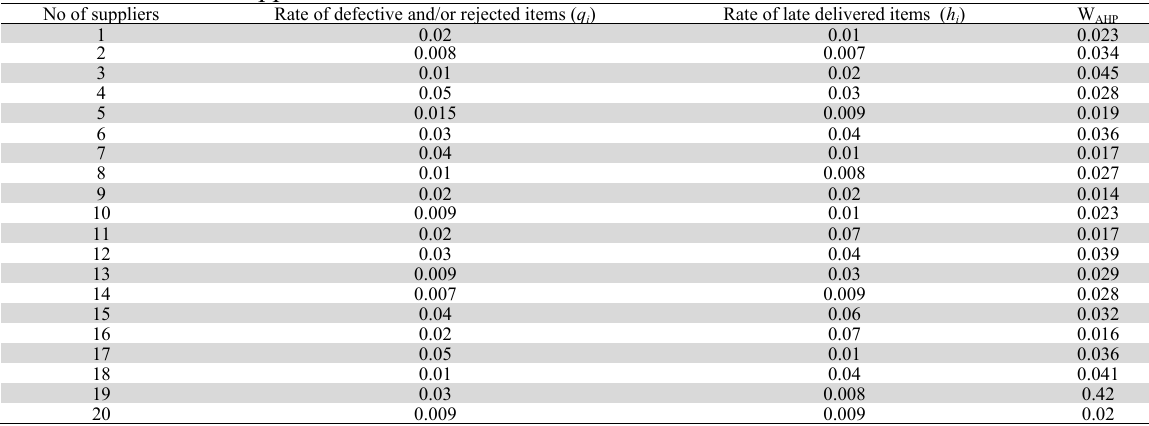
Data related to each supplier No of